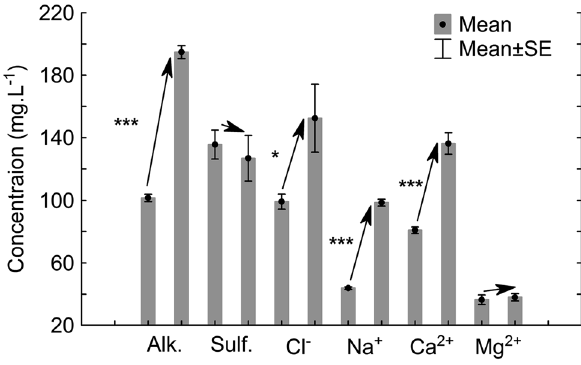
Fig. 4 Mean levels of some parameters in input and output